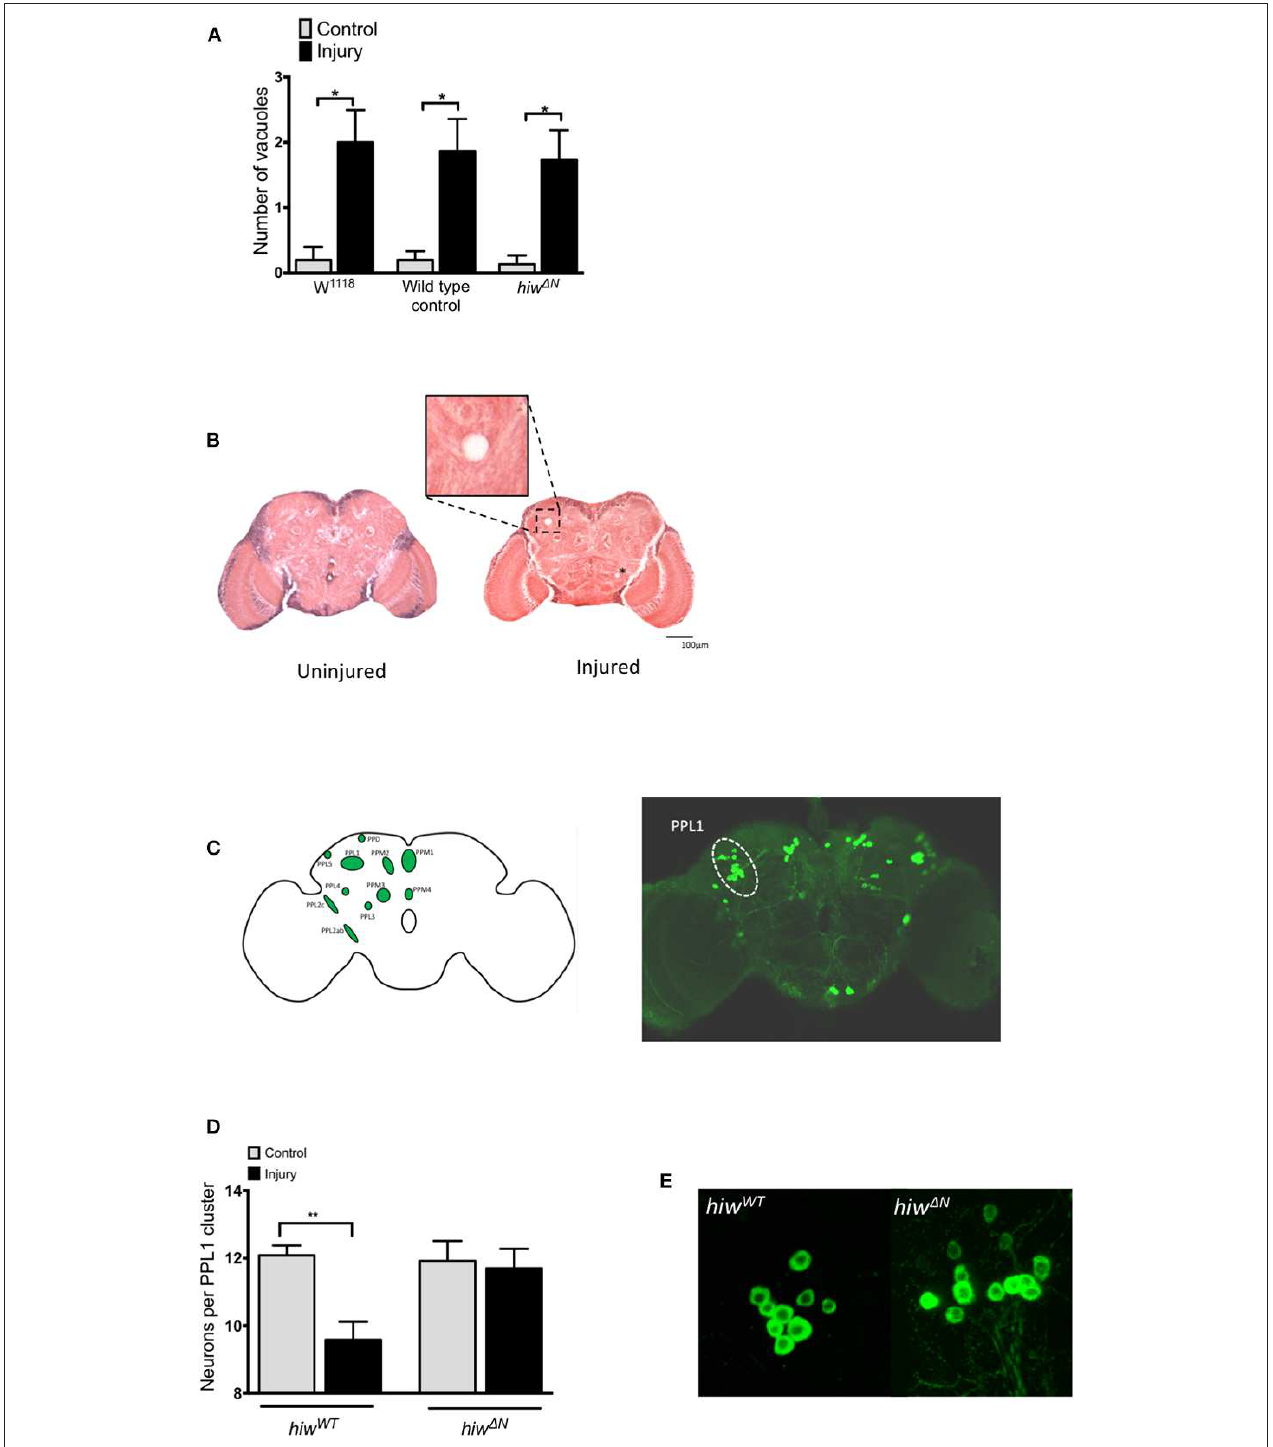
FIGURE 3 | Injured flies develop brain vacuoles regardless of genotype, but depletion of PPL1 cluster dopaminergic neurons that is prevented by highwire mutation. (A) Rates of vacuolation seen by hematoxylin and eosin staining in central brain regions at 28 in hiw 1 N and hiw WT flies 28 days following injury. n = 5 per condition. Error bars show standard error of the mean. Statistical analysis was with two-way ANOVA test. * p ≤ 0.05. (B) Representative hemotoxylin and eosin stained brain sections from uninjured and injured hiw WT flies. The insert shows a close up of a typical vacuole. A further small vacuole is marked by an asterix. (C) Schematic